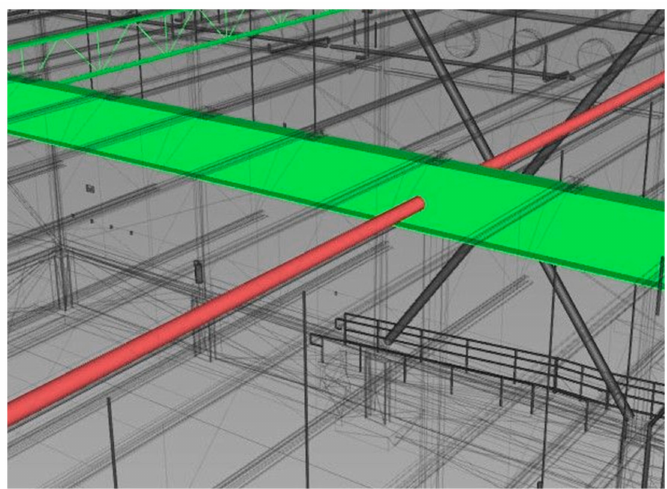
Figure 4. Example of a clash between a structure and the MEP